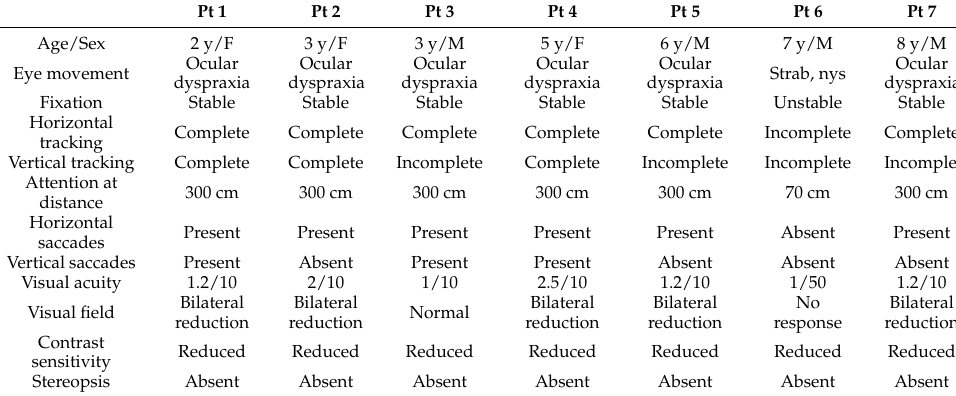
Table 2. Visual function